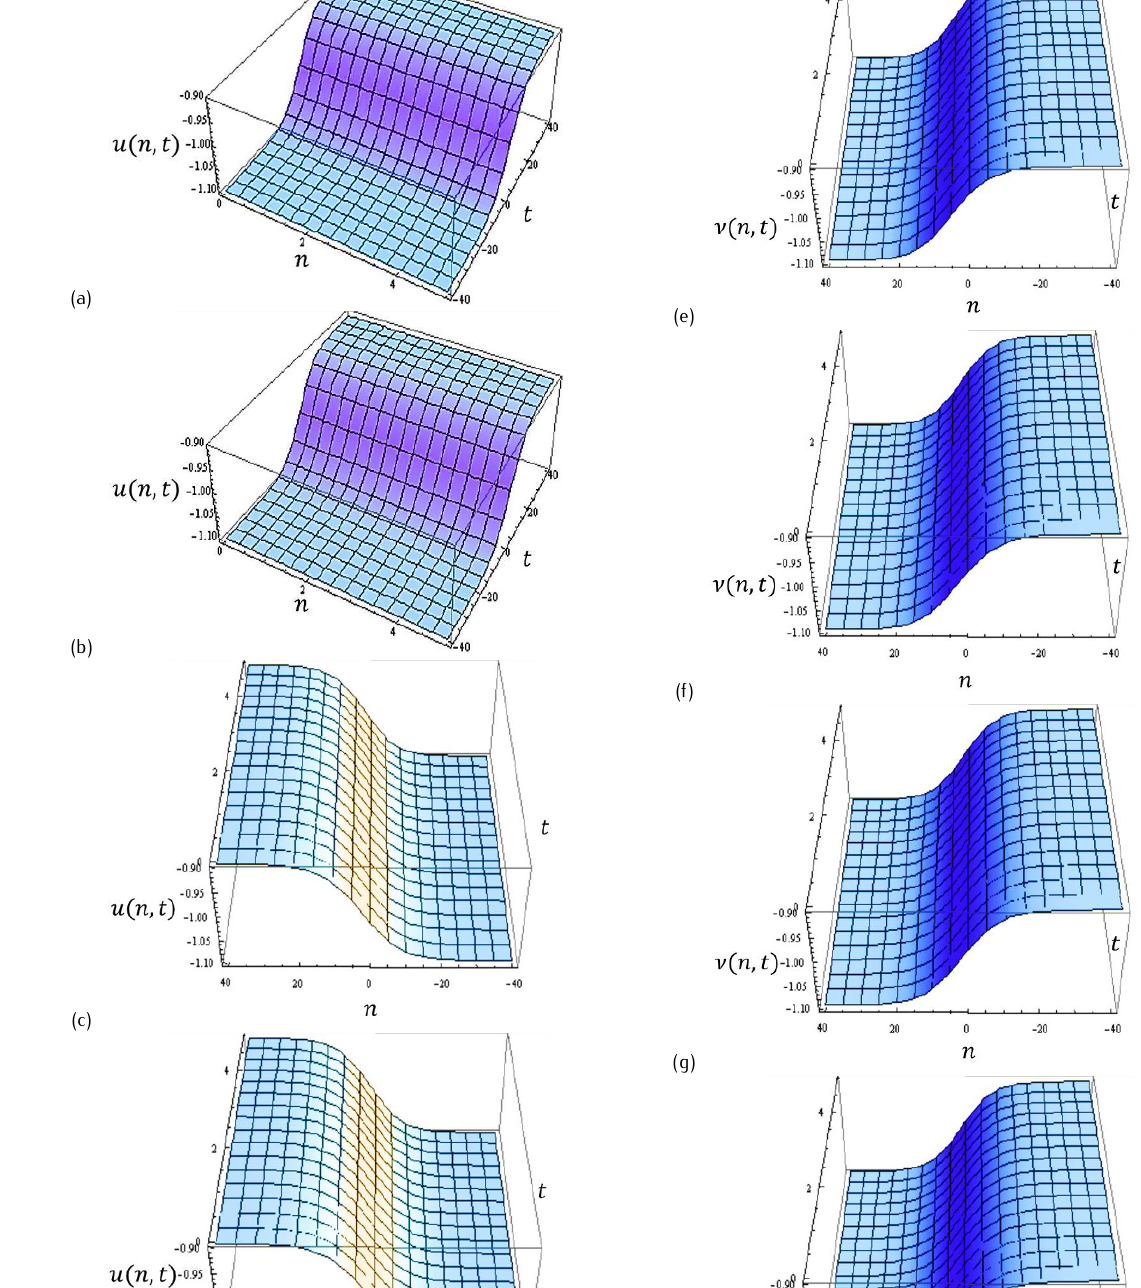
( 40) (a) at µ = 1 , λ = 1 ; (b) µ = 1 ; (d) µ = 1 , λ = 1 with c = 0 . 1 , d = 0 . 1 . λ = 1 3 4 4